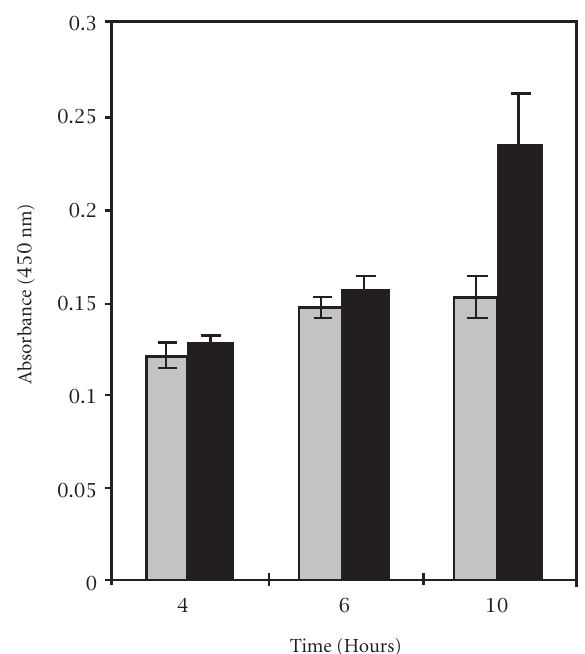
Figure 6: Degradation of chromatin into free nucleosomes of HeLa cells treated with 10 µ g/ml tamoxifen (black bars) compared to the control (gray bars),detected by the Nucleosome ELISA assay.Absor- bance (450nm) is a function of time after the drug treatment. Ten hour treatment period is significantly different from the control.